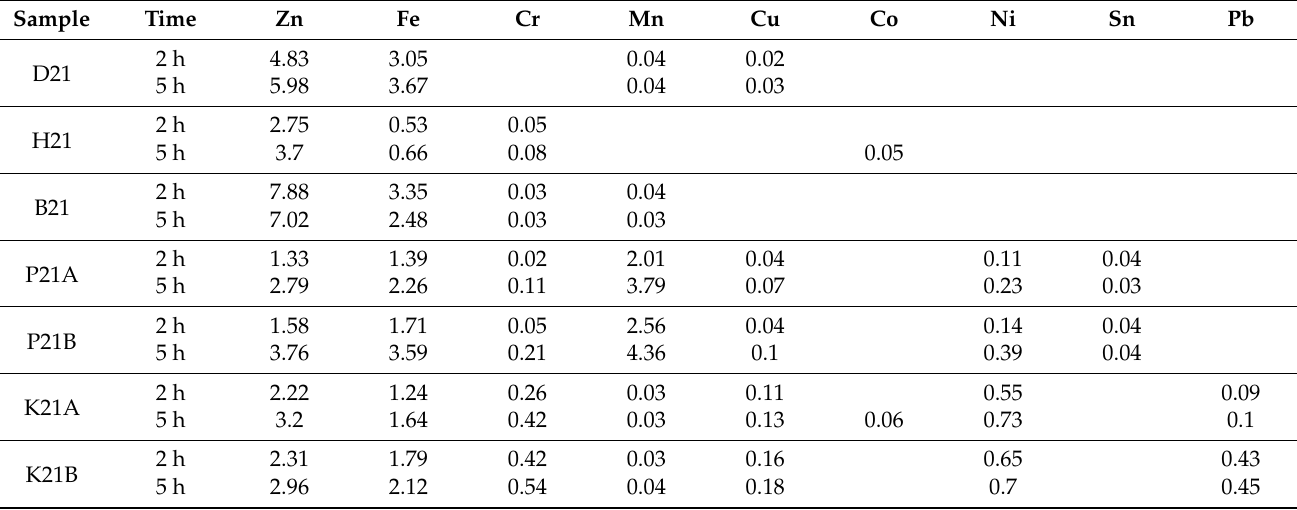
Table 5. ED-XRF results of leaching residues (wt.%) after leaching of various kinds of input sludge (20% of H 2 SO 4 , 50 ◦ C and an addition of 40 mL of H 2 O 2 depending on a time of sampling of 2 or 5